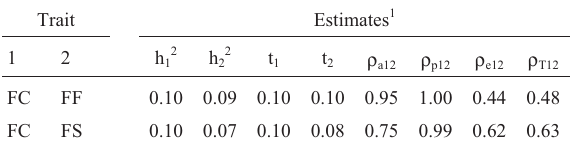
Table 6 - Heritability, repeatability and genetic and phenotypic correlationsofnumberoffliescountedonanimals(FC),numberoffliesin photographs (FF), and infestation score (FS), obtained by the two-trait